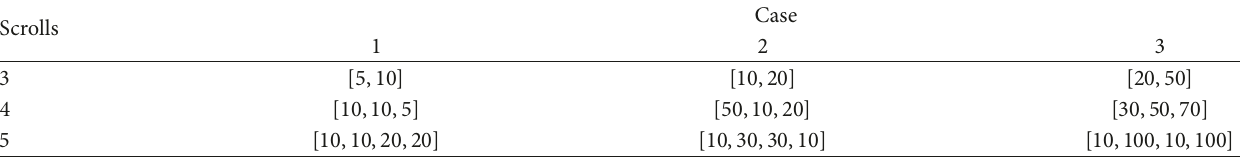
Table 3: Combinations of different slopes for realizing irregular SNLFs generating 3 to 5 scrolls.